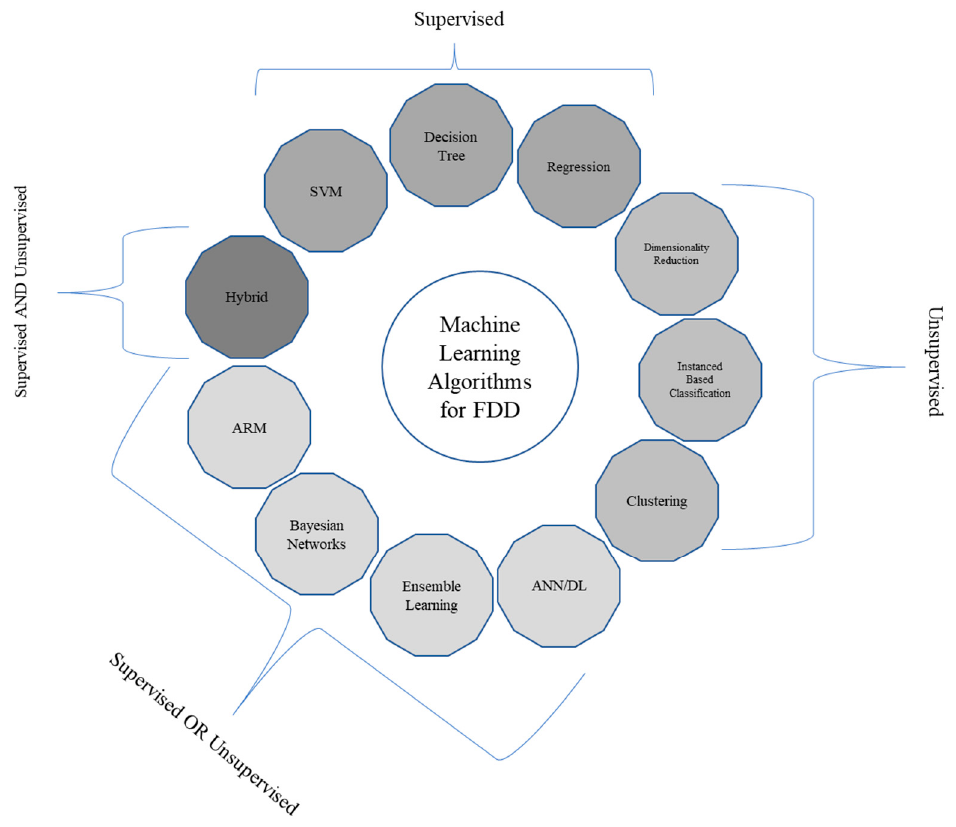
Figure 2. Machine learning FDD algorithms based on learning type.